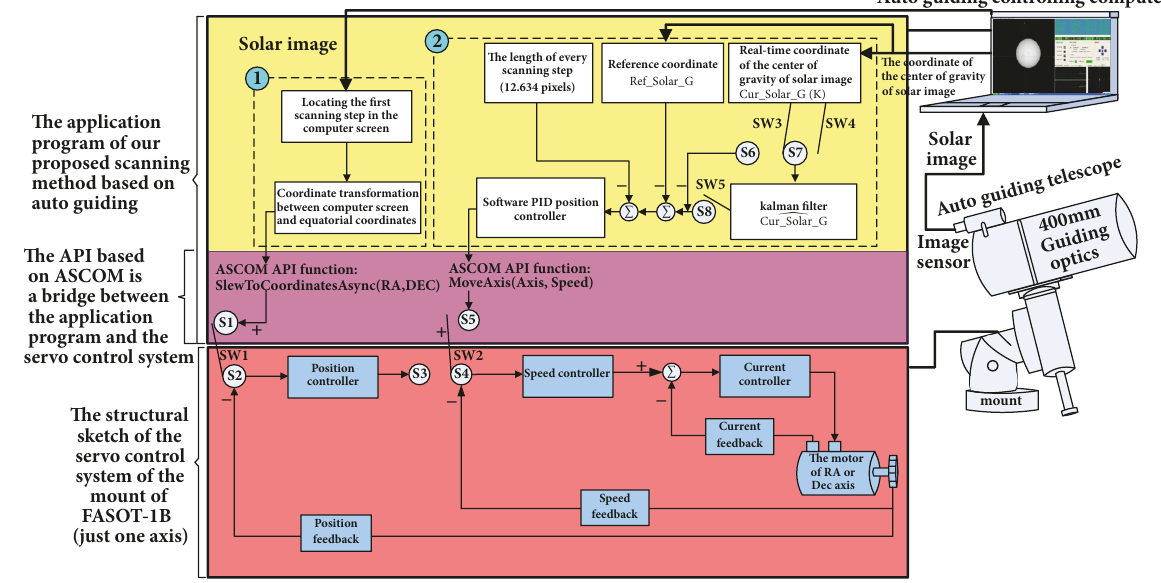
Figure 3: The software structure diagram of the proposed scanning method.